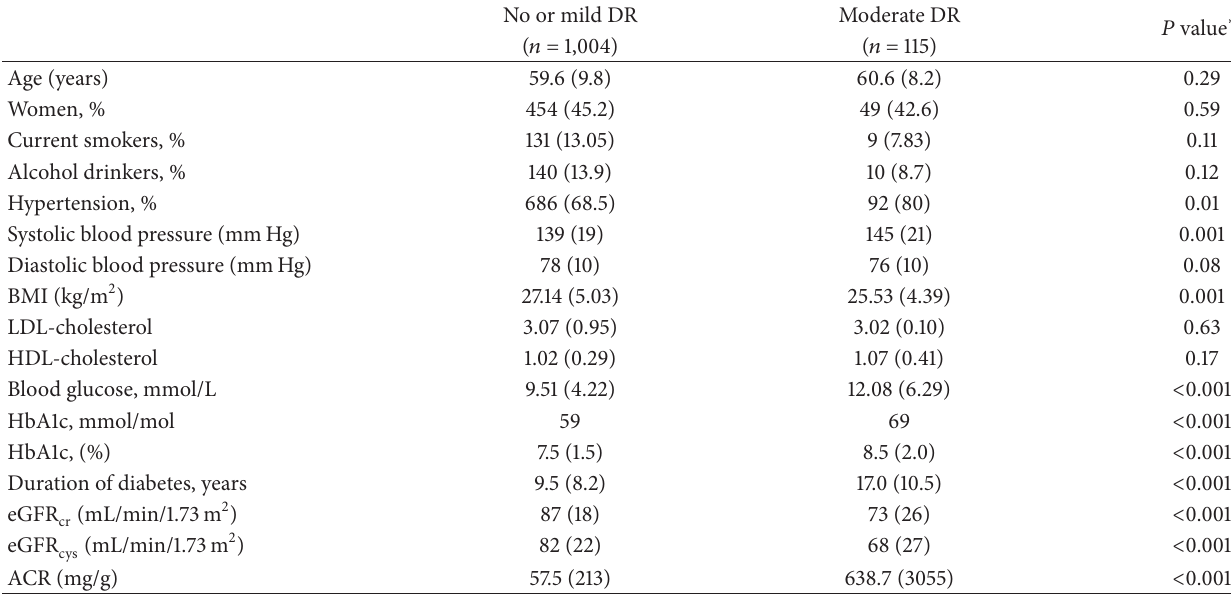
Table 1: Characteristics of participants by moderate DR status.